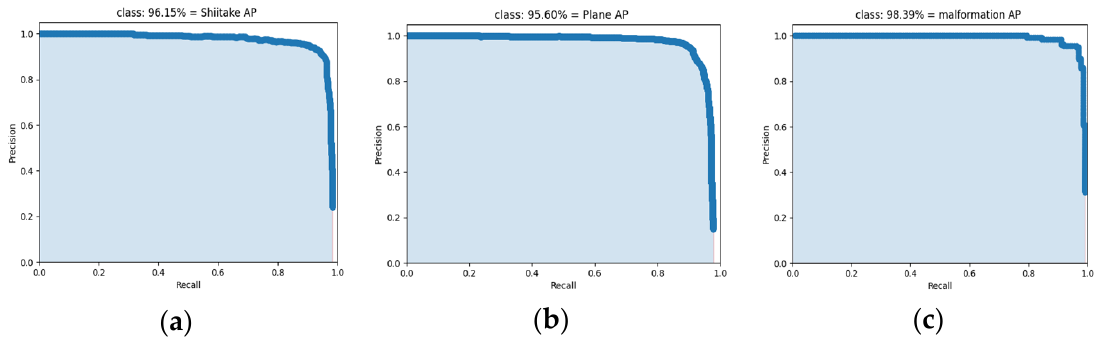
Figure 12. 𝑃 − 𝑅 curves of the YOLO-M detection model. ( a ) Cracked-surface mushroom; ( b ) Plane-surface mushroom; ( c ) Malformed-surface mushroom. Table 3. Training time and migration learning experiment results (IoU threshold set to 0.5).